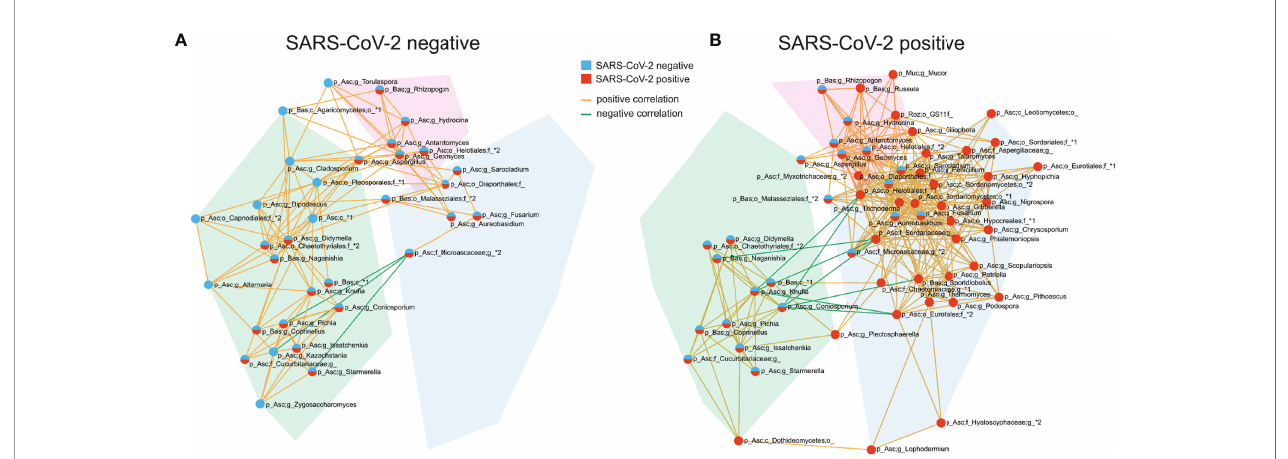
FIGURE 5 | Co-occurrence networks offungalgenera inSARS-CoV-2 negative (A) andSARS-CoV-2 positive patients (B) . The interconnected communities are visualized bytransparent polygons inblue, green andpurple. Nodes represent fungalgenera and the colour of the nodes visualizes the group association.Genera included inthe SARS-CoV-2 negative interconnected community are illustrated inblue, SARS-CoV-2 positive in redand genera included in interconnected communities of both groupsare illustrated inblue and red. Genera exhibiting positive correlationsare connected byorange lines, genera exhibiting negative correlations are connectedby green lines. Each node islabelled with the genus orthe highest taxonomic level that could beassigned byUNITE database and with the phylum(p_)the genus isassigned to. The phylum names are abbreviatedin the fi gure: Asc, Ascomycota; Bas, Basidiomycota; Muc, Mucoromycota;